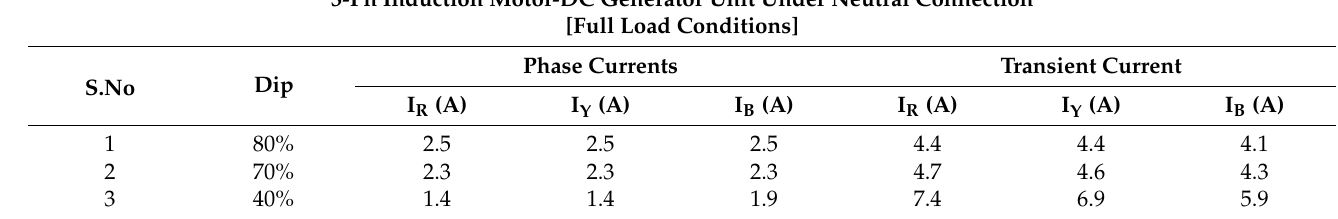
Table 4. IM-DC generator set under loaded conditions [neutral not